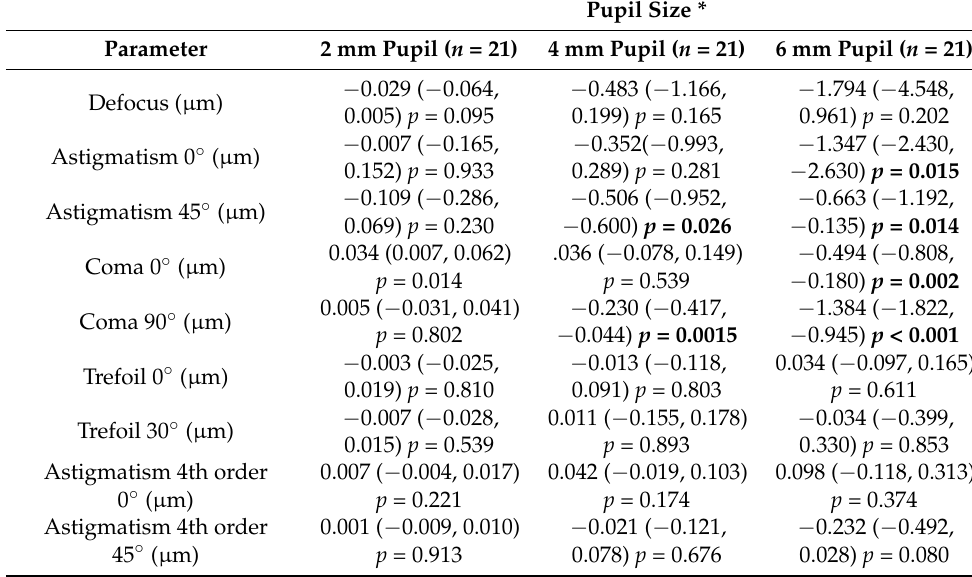
Table 2. Intrastromal corneal ring segments effect on different pupil sizes. Differences pre- and post-operative were calculated from absolute values. Negative coefficients indicate reduction for a given parameter after